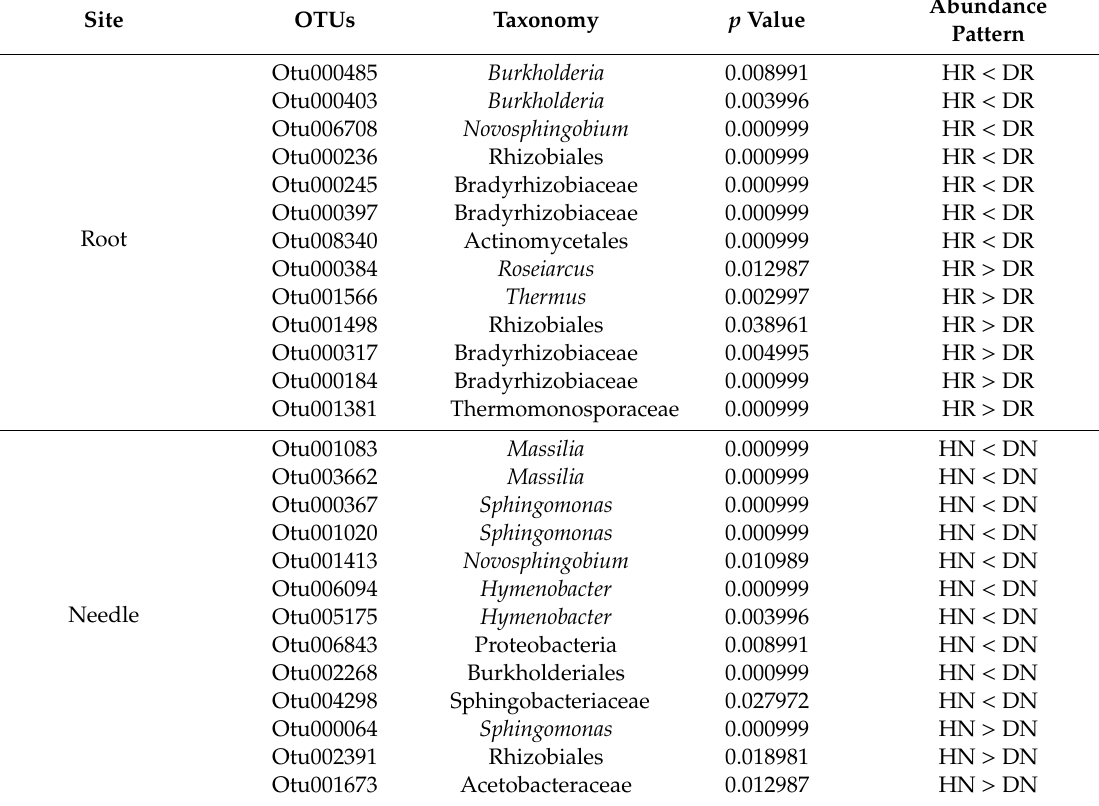
Figure 4. Principal co-ordinates analysis (PCoA) showing the bacterial community structure in healthy and diseased samples in the needles, roots, and soil. Table 2. The list of the top 13 (>0.04%) OTUs showing significant differences in the abundance between healthy (H) and diseased (D) trees in the roots (R), needles (N), and soil (S).